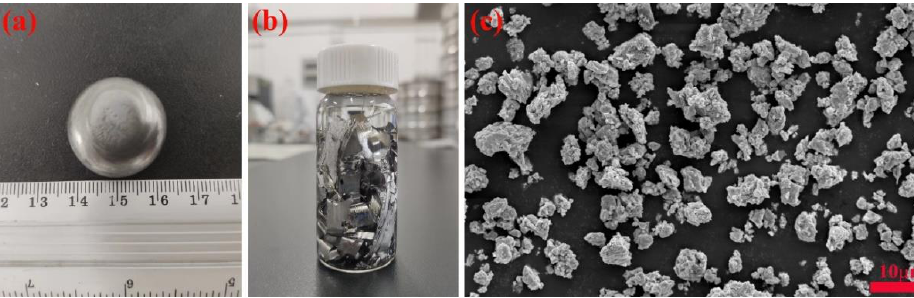
Figure 2. ( a ) Appearance of Ce 72 Cu 28-x Al x alloy ingot, ( b ) rapid quenching strip, and ( c ) microstructure morphology of alloy powder. Table 1. Oxygen content (ppm) summary of Ce 72 Cu 28-x Al x alloy strip and powders after ball